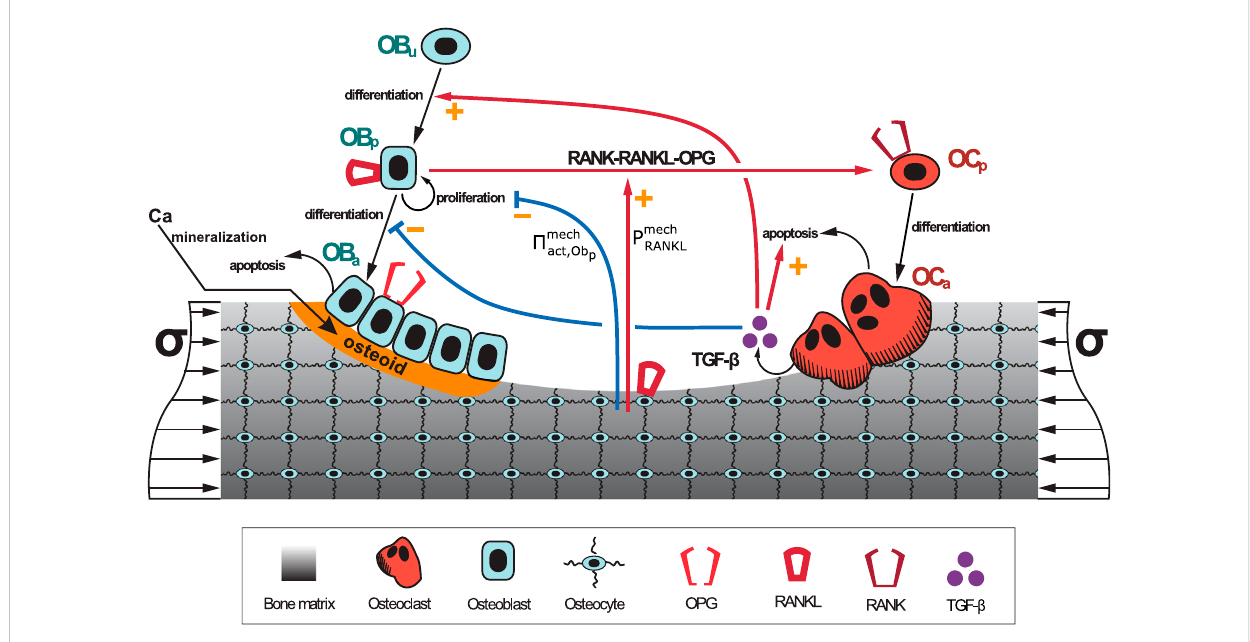
FIGURE 1 Schematic representation of the BCPM developed in (Martínez-Reina et al., 2021b): bone cell differentiation stages along with biochemical and biomechanical interactions are presented. The mineralisation of osteoid is shown in